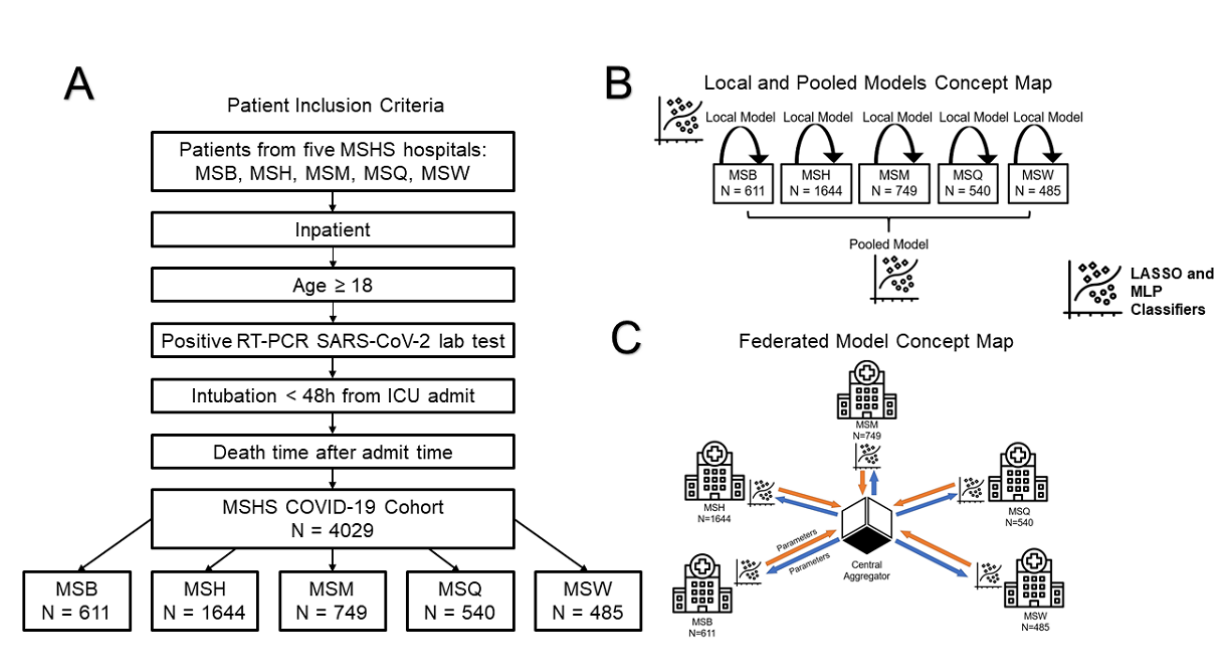
Figure 1. Study design and model workflow. (A) Criteria for patient inclusion in this study. (B) An overview of the local and pooled models. Local models only used data from the site itself, whereas pooled models incorporated data from all sites. Both the local and pooled MLP and LASSO models were used. (C) An overview of the federated model. Parameters from a central aggregator are shared with each site, and sites do not have direct access to clinical data from other sites. After the models are locally trained at a site, parameters with and without added noise are sent back to the central aggregator to update federated model parameters. Federated LASSO and MLP models were used. LASSO: least absolute shrinkage and selection operator; MLP: multilayer perceptron; MSB: Mount Sinai Brooklyn; MSH: Mount Sinai Hospital; MSM: Mount Sinai Morningside; MSQ: Mount Sinai Queens; MSW: Mount Sinai